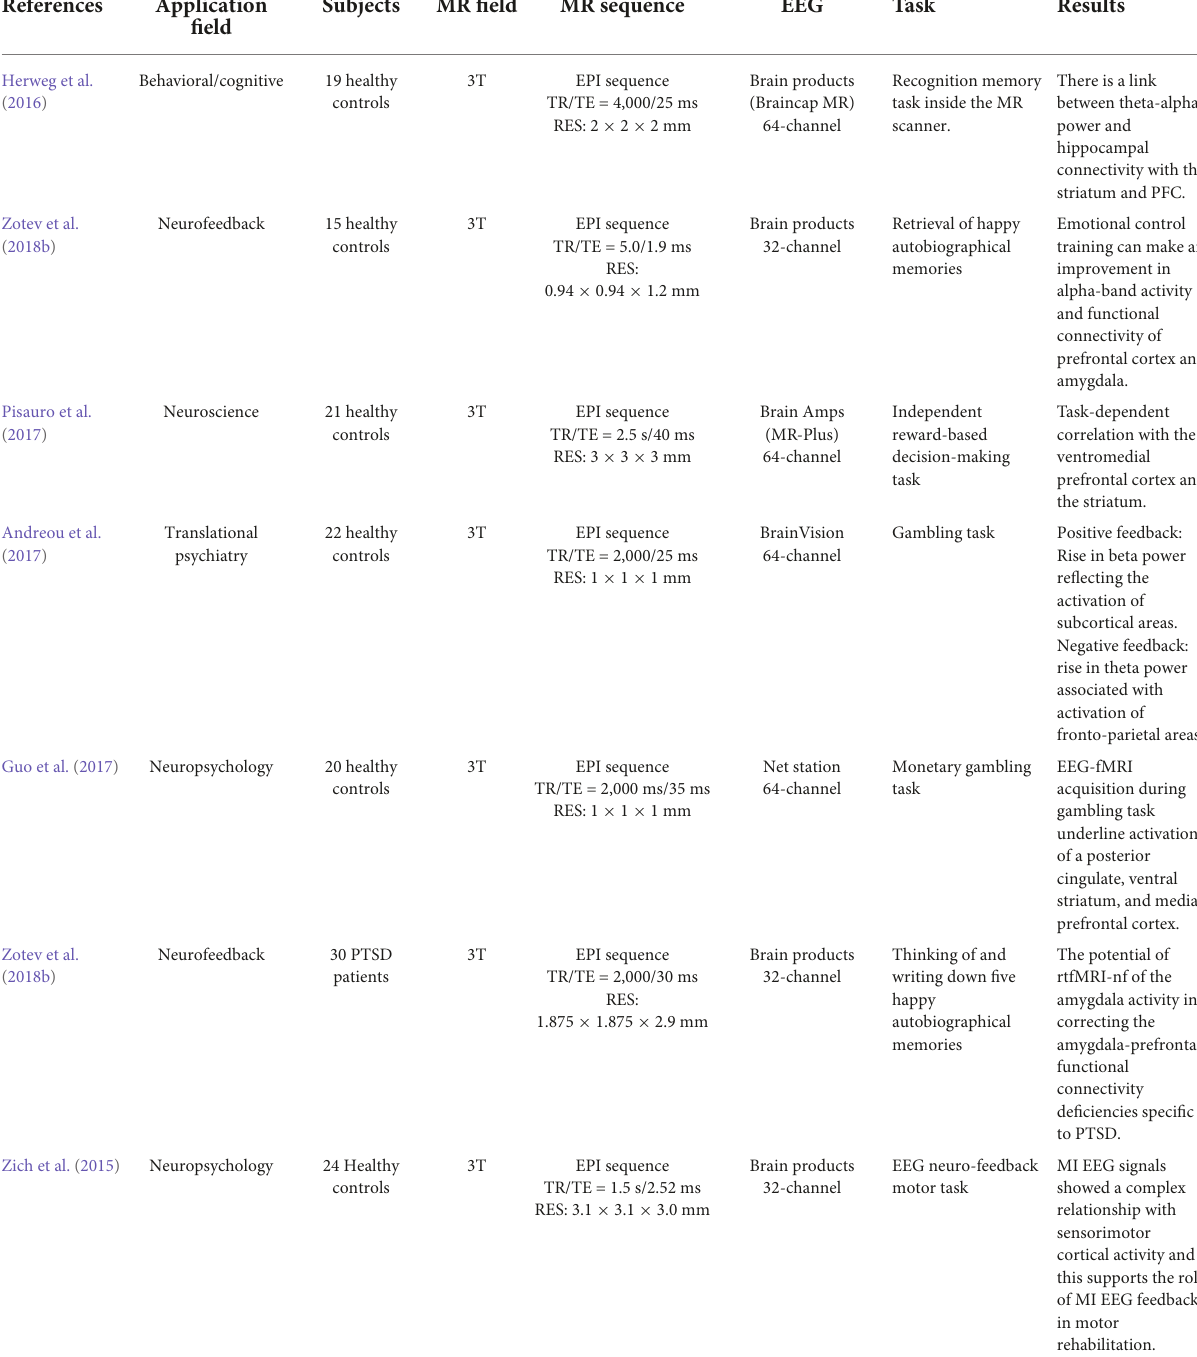
TABLE 2 A summary of the task EEG-fMRI studies since